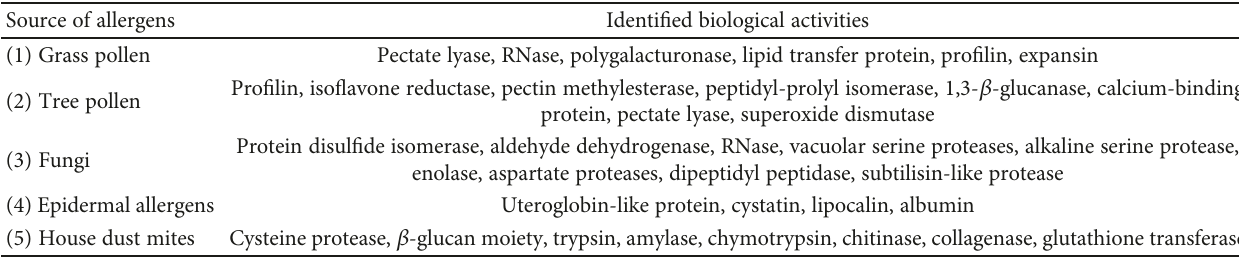
Table 1: Immunologically active